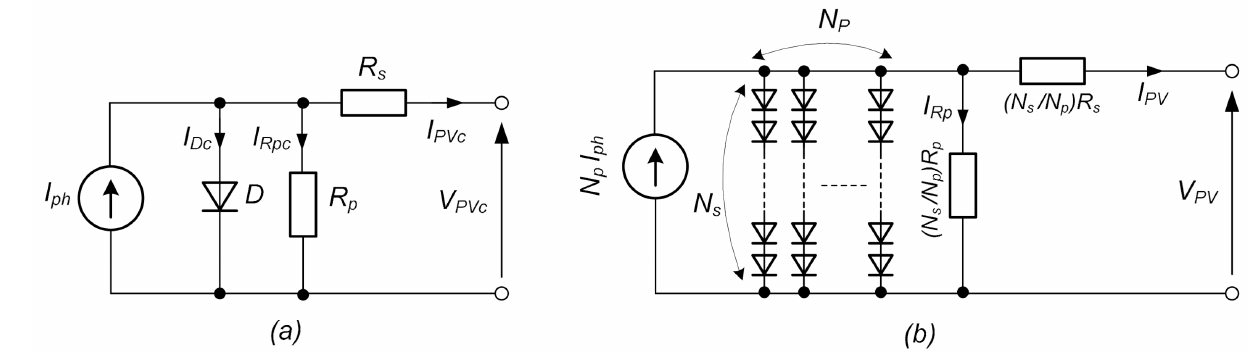
Figure 5. The equivalent circuit of a PV cell ( a ) and the equivalent circuit of a PV array ( b